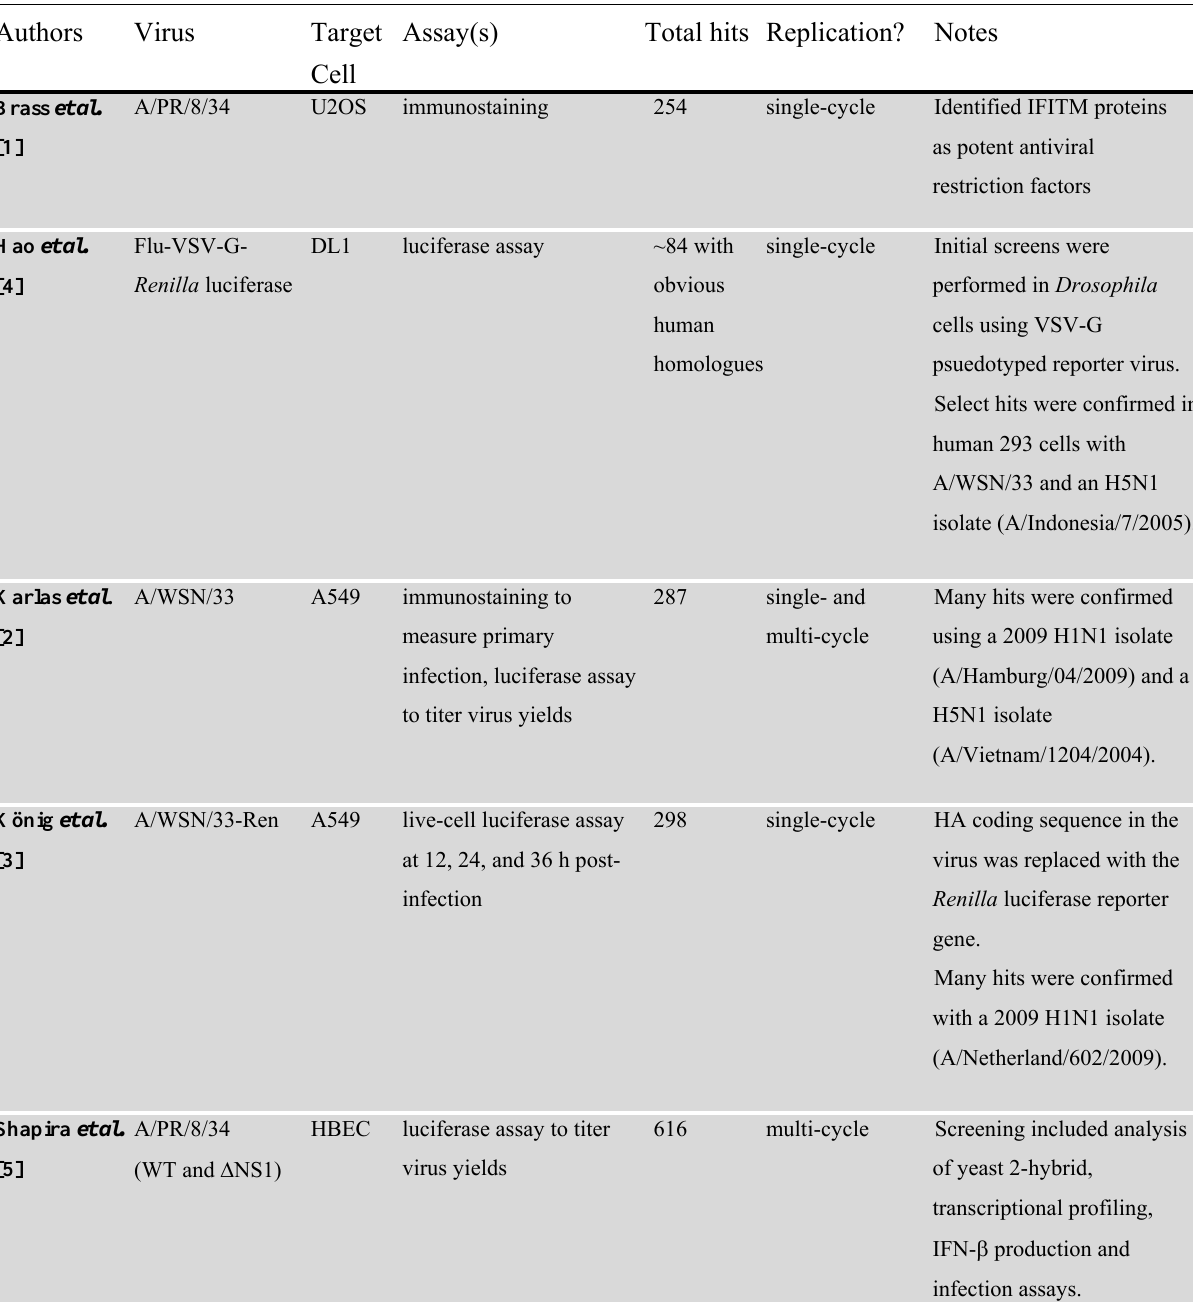
Table 1. Comparison of screens performed to identify host factors for influenza virus